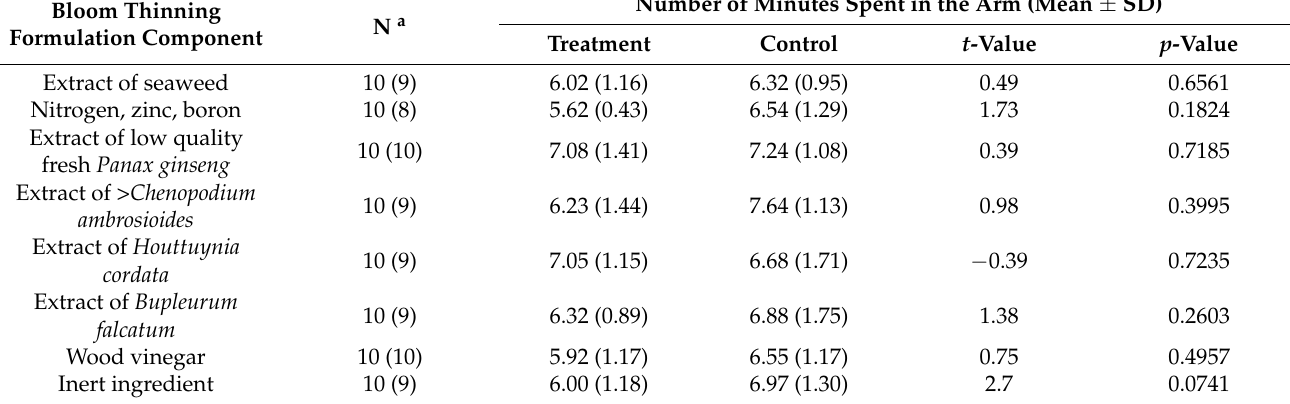
Table 3. The average time spent by Apis mellifera worker bees in a Y-tube olfactometer with each component of bloom thinning formulations at 1%